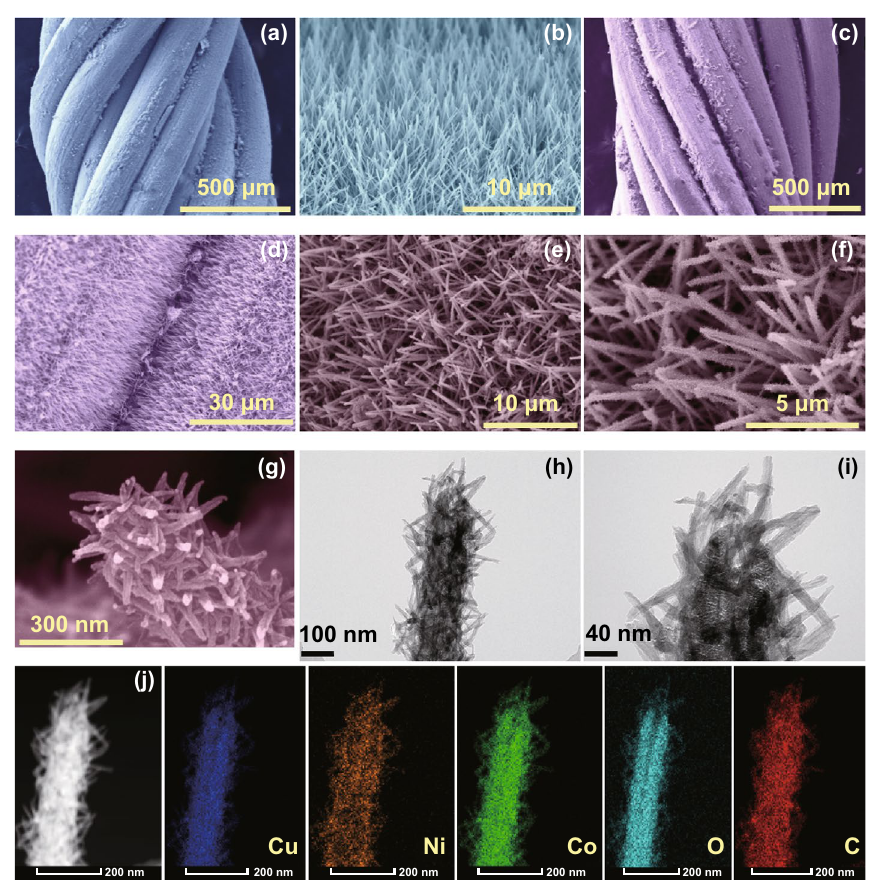
Fig. 2 FE‑SEM images for the a , b Cu(OH) 2 /Cu wire, c , d NiO/CuO/Cu, and e–g NiCo‑hydroxide/NiO/CuO/Cu electrodes. h , i TEM images for the NiCo‑hydroxide/NiO/CuO/Cu electrode. j STEM‑EDS elemental mapping results for the NiCo‑hydroxide/NiO/CuO/Cu